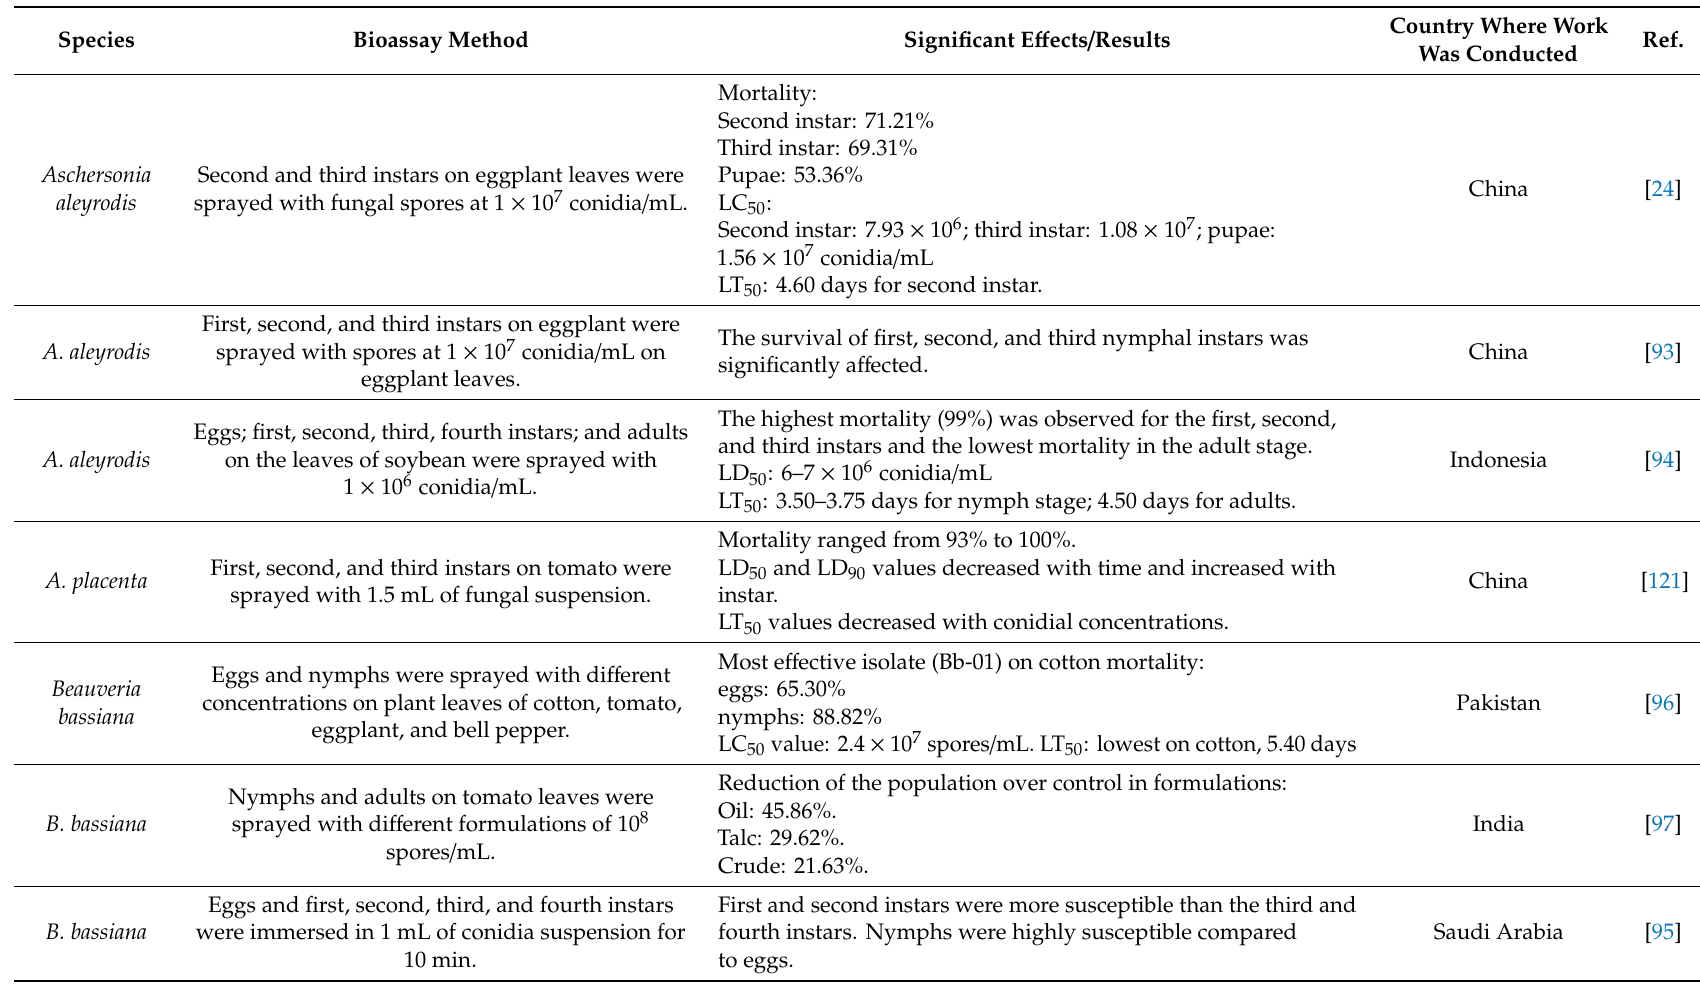
Table 1. Summary of control methods of B. tabaci using entomopathogenic fungi